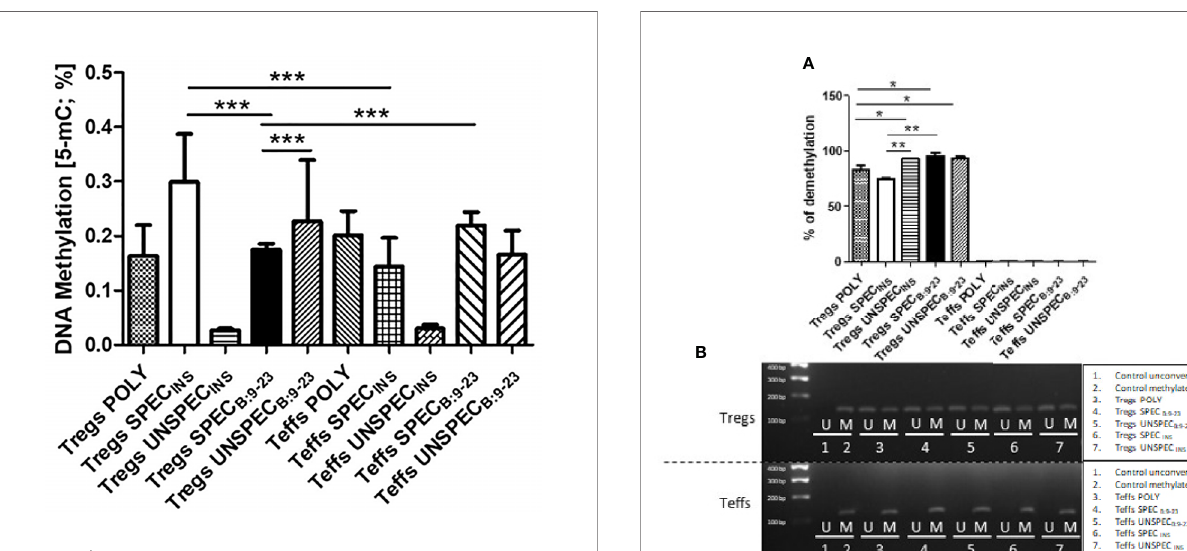
FIGURE 4 | Global DNA methylation in Tregs and Teffs. Comparison of 5- methylocytosine (5-mC) production in Tregs: POLY, SPEC, UNSPEC and Teffs: POLY, SPEC, UNSPEC. During the tests cells were stimulated with beads anti-CD3/ant-CD28 (index POLY) or monocytes loaded with whole insulin (index INS) or insulin b chain peptide 9-23 (index B:9-23). Cells responding to antigen have an index SPEC, cells not recognizing the antigen have an index UNSPEC. All analyzes were performed for six tests (three tests for whole insulin and three tests for insulin b chain peptide 9-23) in triplicate. The results are presented as mean+/- SD. Signi fi cance was calculated using the t- test, signi fi cant results are marked with * (p<0.05), ** (p<0.01) or ***(p<0.001).